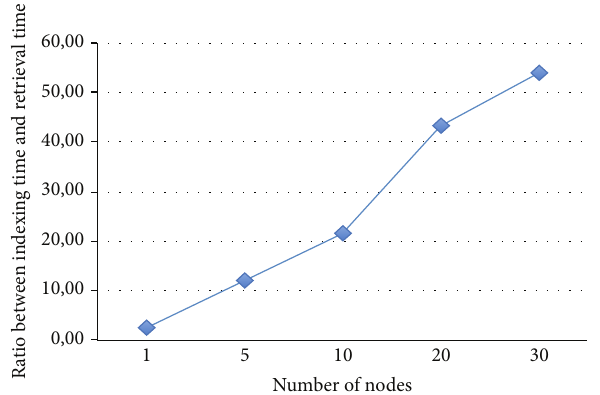
Figure 5: Ratio between indexing time and retrieval time with respect to the number of nodes for the system proposed in [17], with a collection made up of 160 K